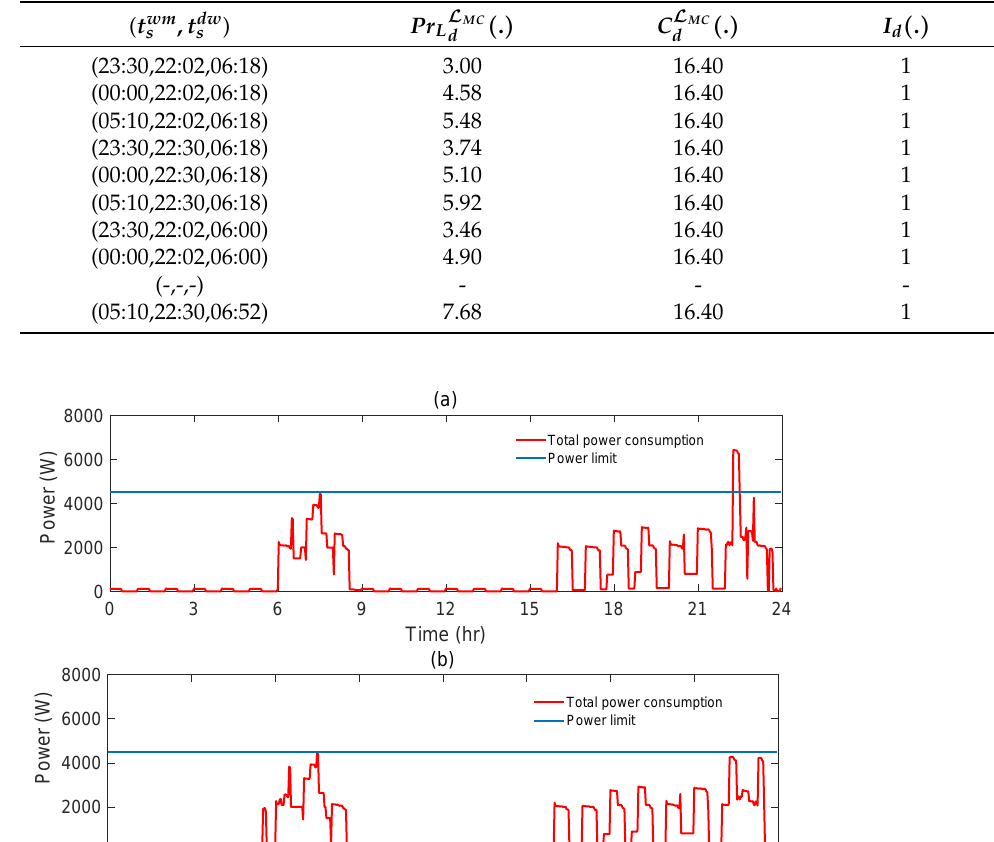
Table 12. For the triplets of starting times with the minimum cost, priority level, electricity cost, power limit indicator values for Scenario 2.